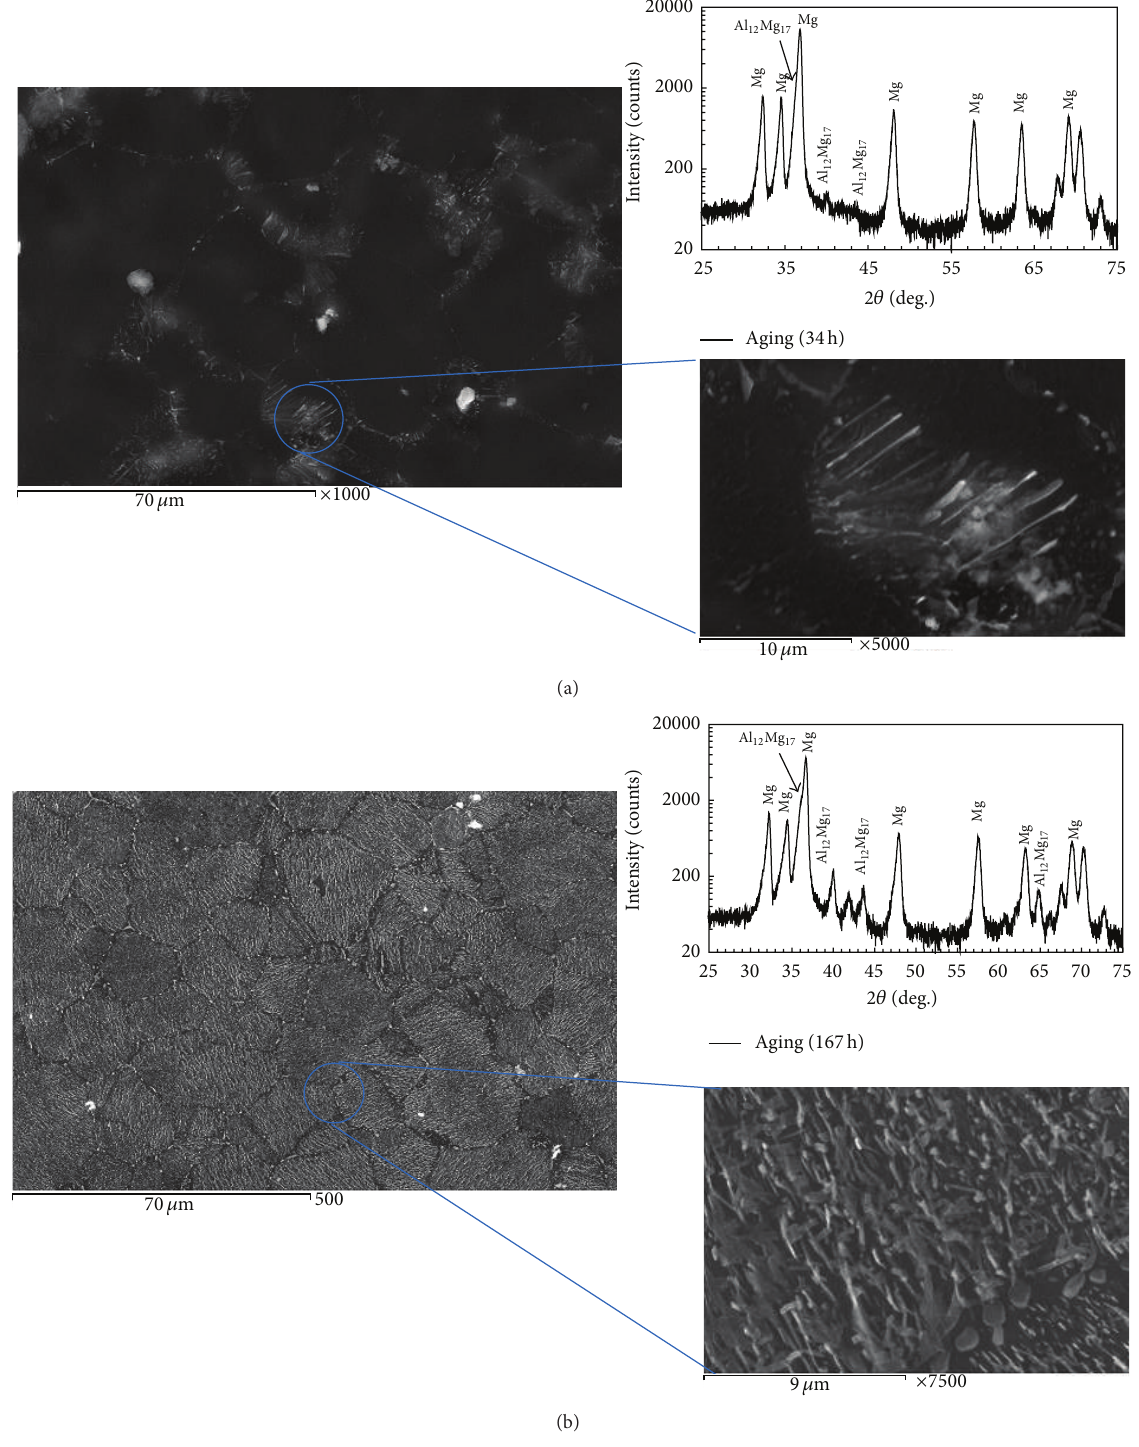
Figure 6: SEM micrograph of aged AZ61 alloy (a) for 34 hr and (b) for 167hr aging times.